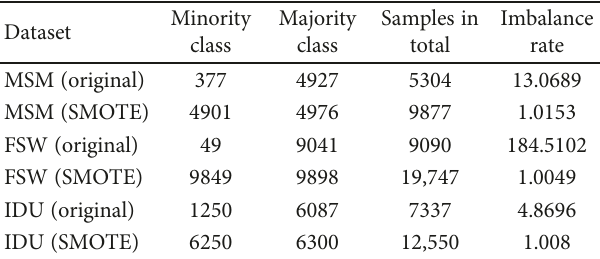
Table 5: Description of original data and balanced data.